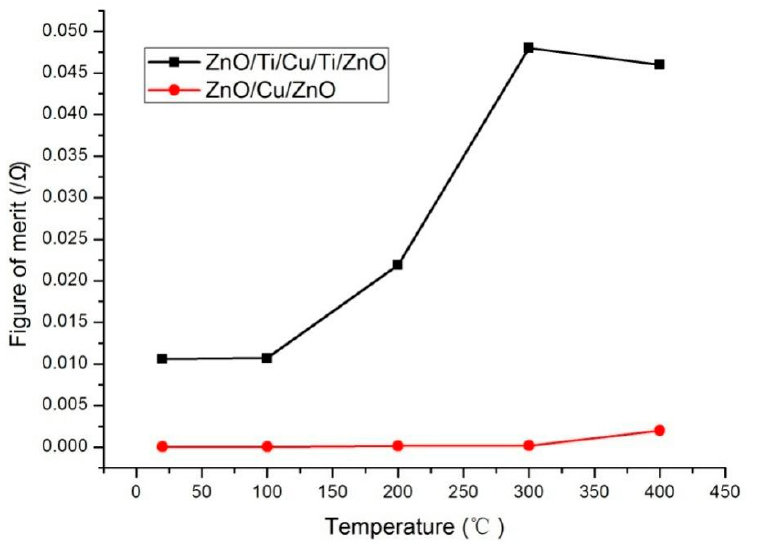
Figure 10. The figures of merit of the ZnO(Cu) and ZnO(Ti/Cu) thin films with varying annealing temperatures.